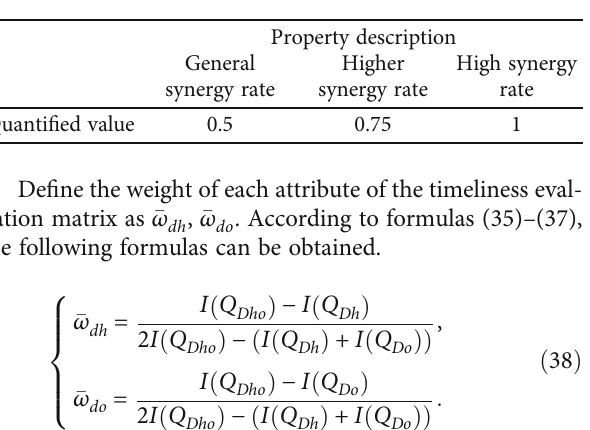
Table 6: Personnel collaboration rate description quantitative